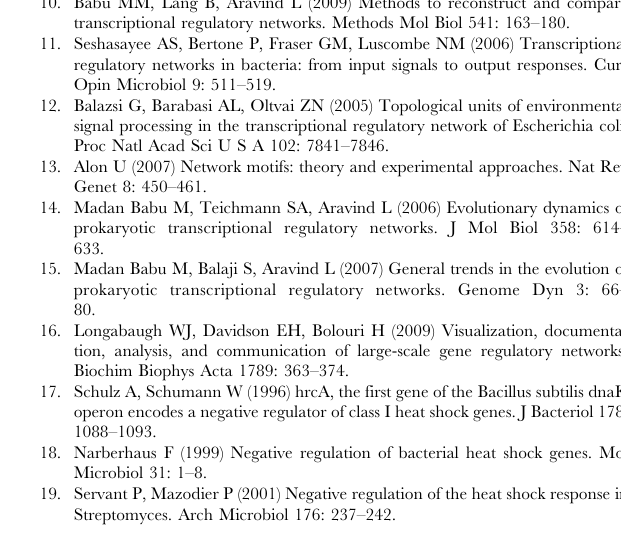
Figure S1 The acid acclimation origon. The acid acclimation origon is wired in two SIMs, controlled respectively, by the phosphorylated (P , ArsR; dark green) or the unphosphorylated (ArsR; red) form of the response regulator. The phospho-transfer event is mediated by the transmembrane histidine kinase ArsS (light green) and may be promoted in the cytoplasm by FlgS (light blue) under harsh acidic conditions. The color code of operons reflects the respective signal transduction pathway, ArsS- or FlgS- dependent (light green and light blue, respectively), or P , inde- pendent (red). TF-DNA interactions and direct transcriptional control are depicted by black lines; arrowheads denote positive regulation; hammerheads indicate negative regulation. Ectopic regulation of Fur and NikR, feeding in from the metal homeostasis origon, is depicted. Found at: doi:10.1371/journal.ppat.1000938.s002 (0.40 MB PDF) Model S1 Zipped folder containing files for the BioTapestry Editor Java plug-in (bioTapestryEditor.jnlp) and the H. pylori TRN model (HpTRN_ModelS1.btp). Found at: doi:10.1371/journal.ppat.1000938.s003 (0.02 MB ZIP) Text S1 Instructions for opening and browsing the H. pylori TRN model with BioTapestry editor and a caption for the model. Found at: doi:10.1371/journal.ppat.1000938.s004 (0.03